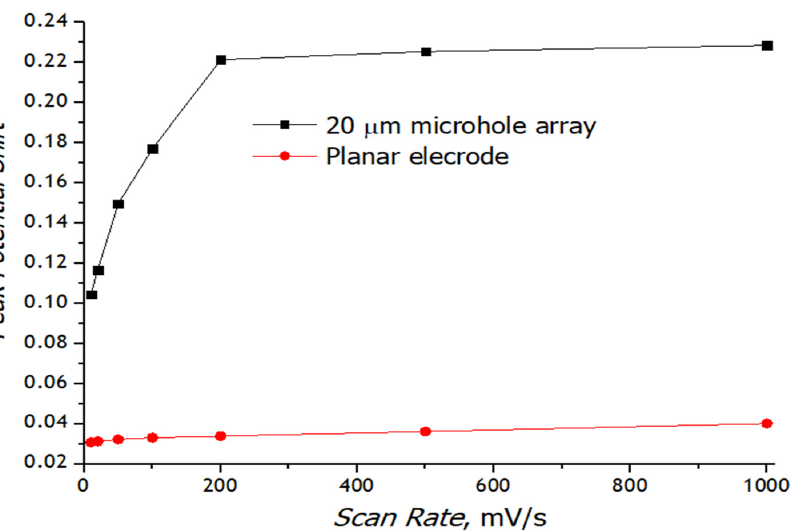
Figure 18. Peak potential shift of triglycine ferrocenemethanol ester calculated from CV measured in the microelectrode ensemble (inter-electrode distance 20 um) and planar gold electrode.